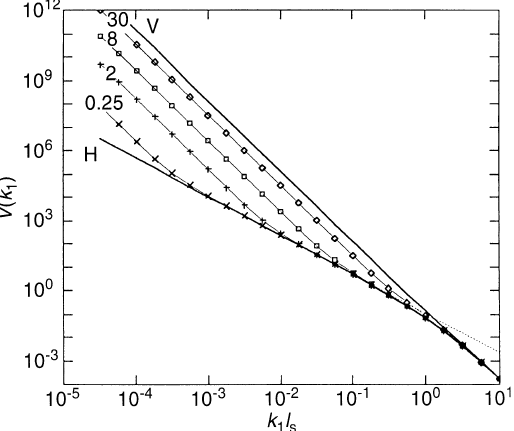
Fig. 5. Oblique 1D spectra at the di(cid:128)erent values of the angle # for (cid:108) (cid:136) 5 and (cid:109) (cid:136) 2. The numbers by the spectra are 90 (cid:14) (cid:255) # , the thick lines correspond to vertical (V) and horizontal (H) 1D spectra, the dotted line is the low-frequency asymptote of the horizontal 1D